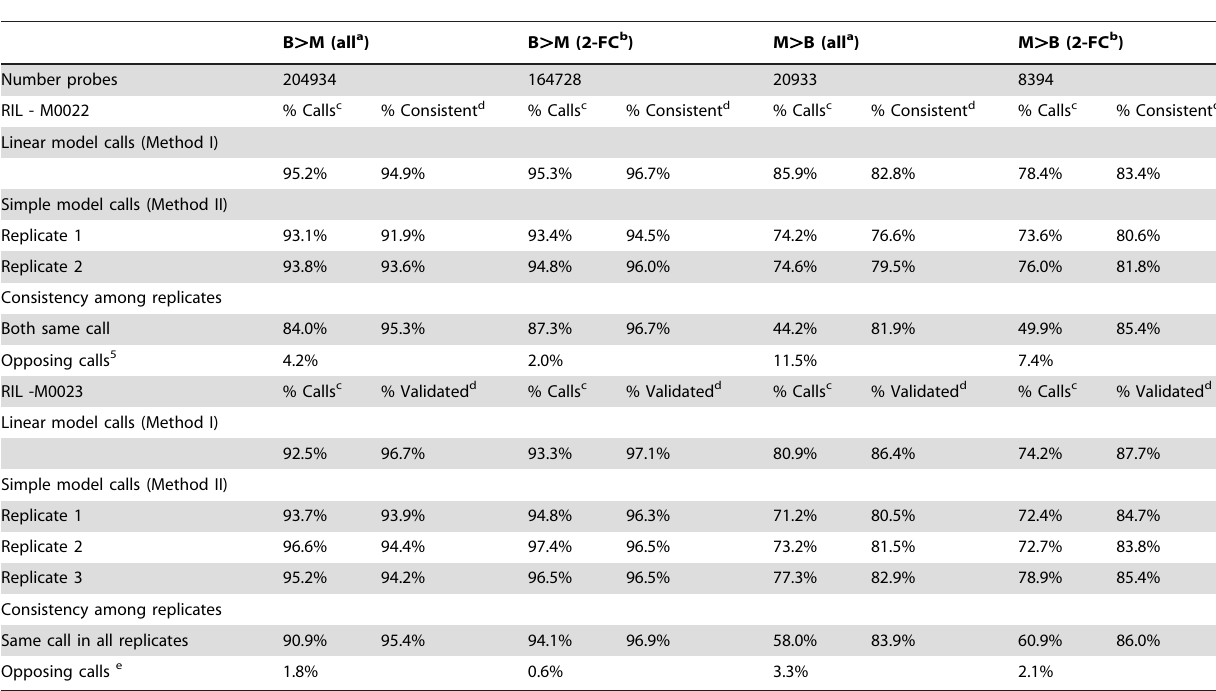
Table 1. Comparison of genotyping using different subsets of probes and multiple analysis